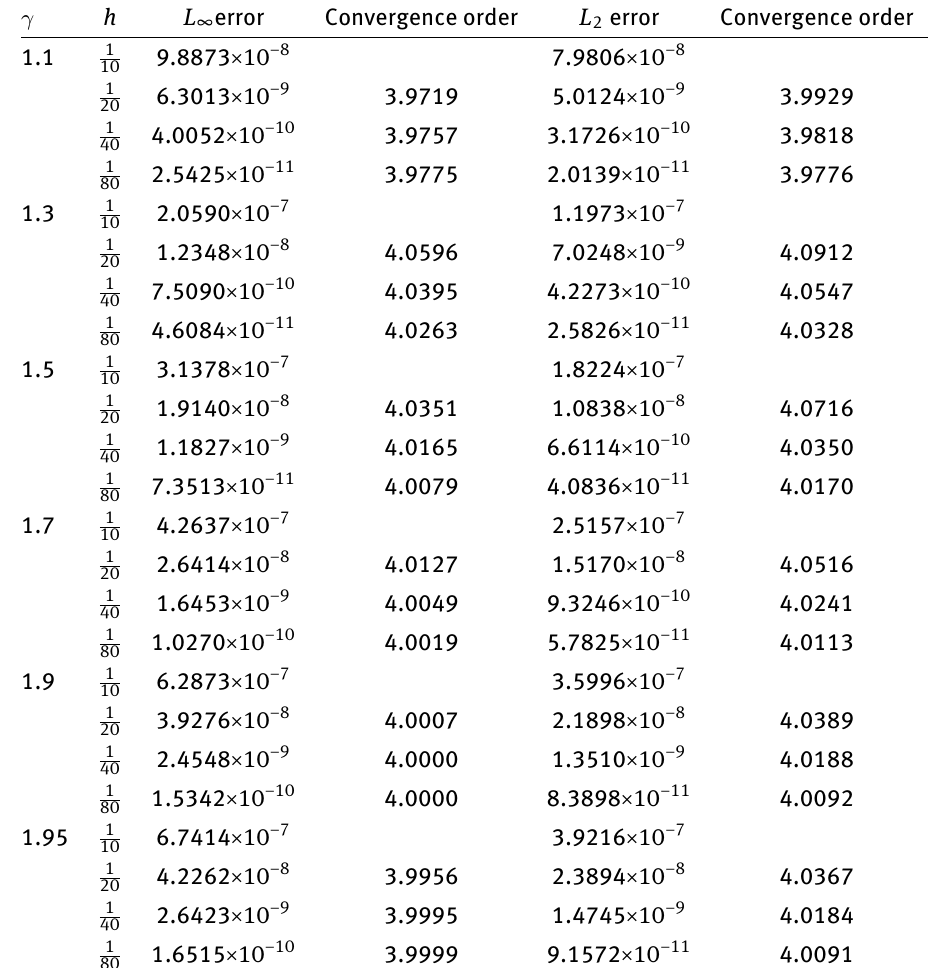
Table 4: The L ∞ , L 2 errors and spatial convergence orders with τ = h 2 for Example